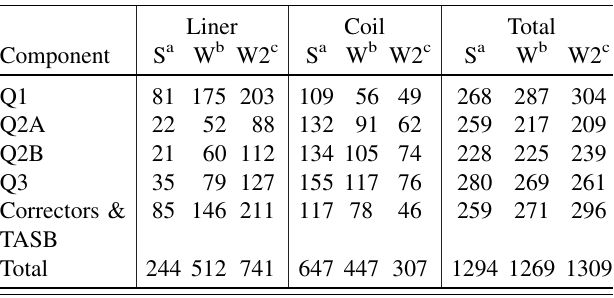
Total a Model with a stainless steel liner of baseline thickness. b Model with a W25 Re liner of baseline thickness. c Model with a W25 Re liner of increased (by 2 mm) thickness.